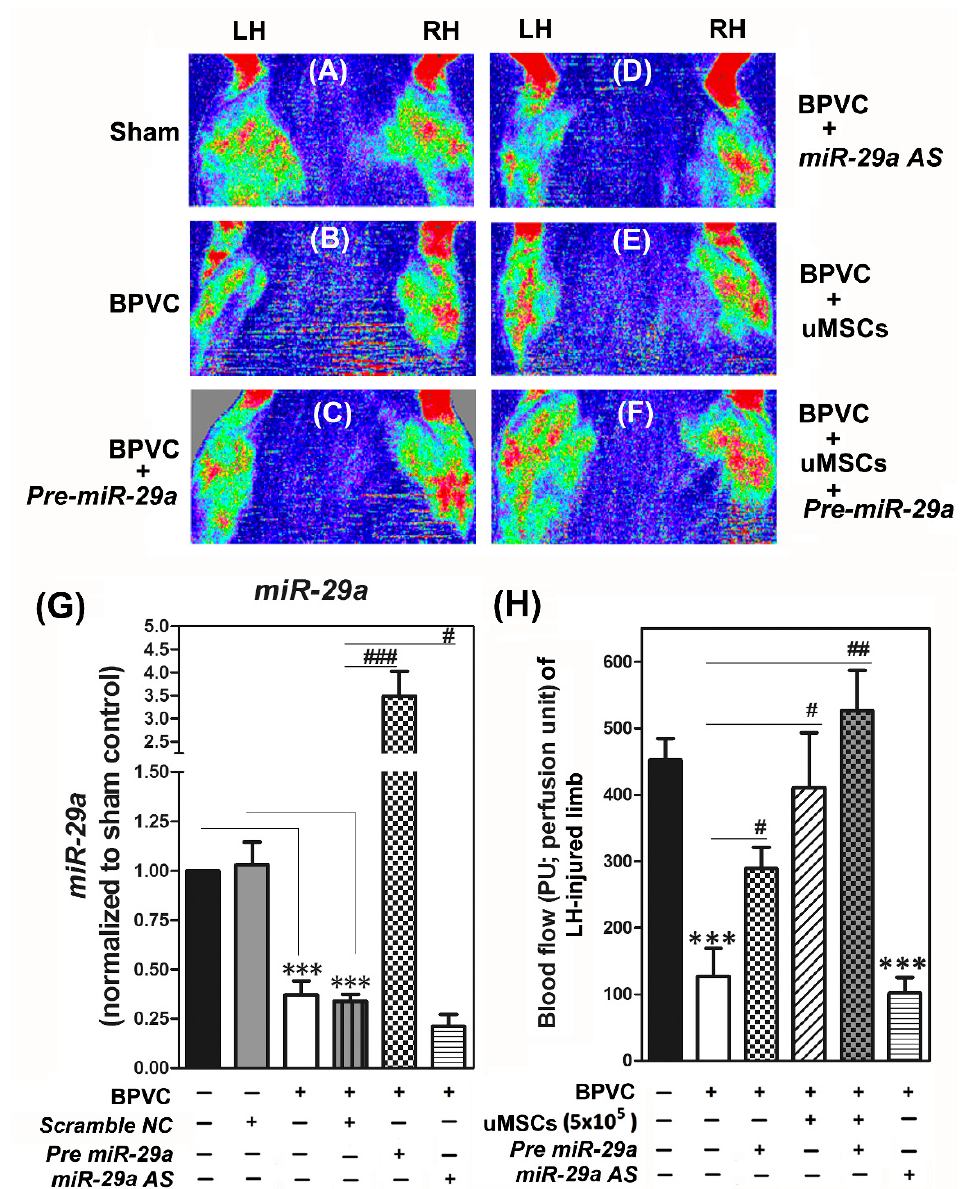
Figure 3. Forced expression of miR-29a or transplantation of human umbilical cord Wharton’s jelly (WJ)-derived mesenchymal stem cells (uMSCs) successfully restored the blood perfusion in the anesthetized C57BL/6 mice post BPVC-injury ( n = 6/each group). Representative laser Doppler perfusion images of both left hind (LH) and right hind (RH) limbs. After 7 days of BPVC injury on the LH limb, impaired blood perfusion was shown in ( B ; LH site), while compared to the saline injected LH limb Sham group ( A ) or its contralateral control RH limb ( B ; RH site). Injection of Pre miR-29a notably rescued the BPVC-suppressed blood perfusion in LH limb ( C ; LH site) whereas the injection of scramble NC (negative control of miR-29a ) into the RH limb did not have any significant restoration on perfusion recovery ( C ; RH site). ( D ) Injection of miR-29a AS (inhibitor of miR-29a ) into BPVC-induced ischemic LH limb aggravated the impairment of blood perfusion. ( E ) Transplantation of uMSCs into BPVC-injured LH limbs considerably restored the perfusion while compared to the BPVC-injured LH limb in ( B ; LH site). Of note, transplantation of uMSCs together with Pre miR-29a conspicuously renovated the BPVC-induced LH limb ischemic perfusion and shown in ( F ). ( G ) Quantitative RT-PCR analysis confirmed that Pre miR-29a injection group strongly displayed miR-29a transcripts in gastrocnemius muscles collected from ( C ; LH site) than those in the scramble NC treatment group collect from ( C ; RH site). In contrast, the level of miR-29a was evidently suppressed in the miR-29a AS treatment groups shown in